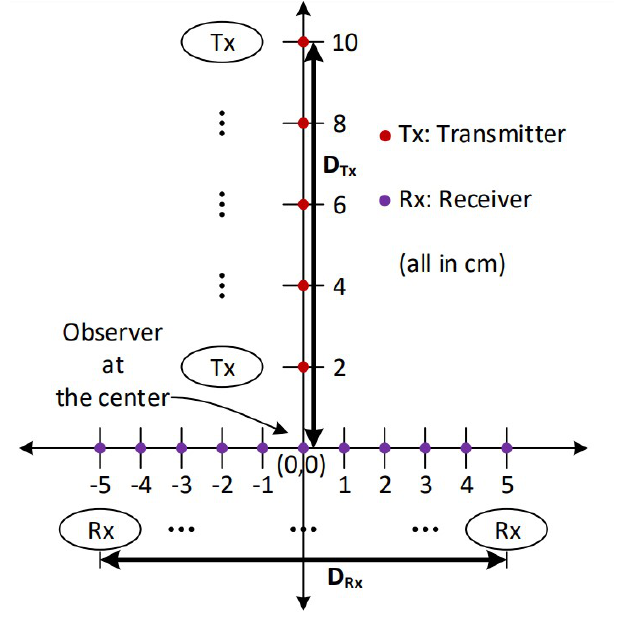
Figure 15. Setup to perform a stress